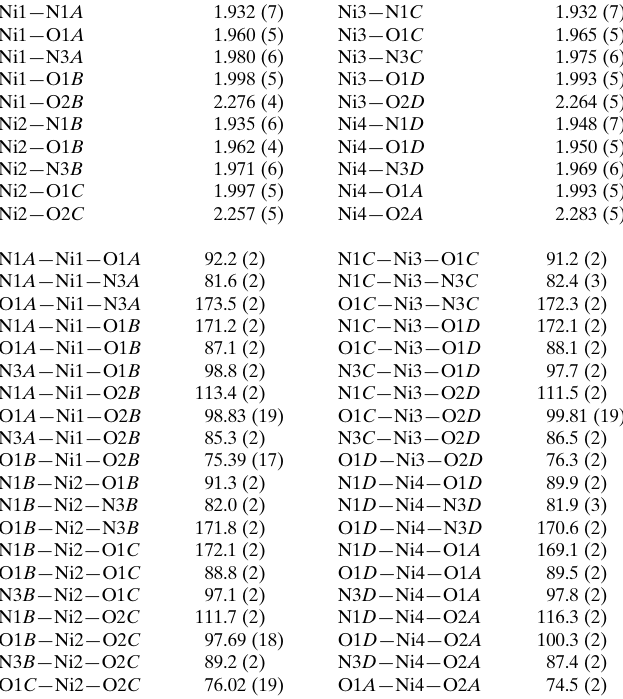
Table 1 Selected geometric parameters (A˚ , (cid:5)